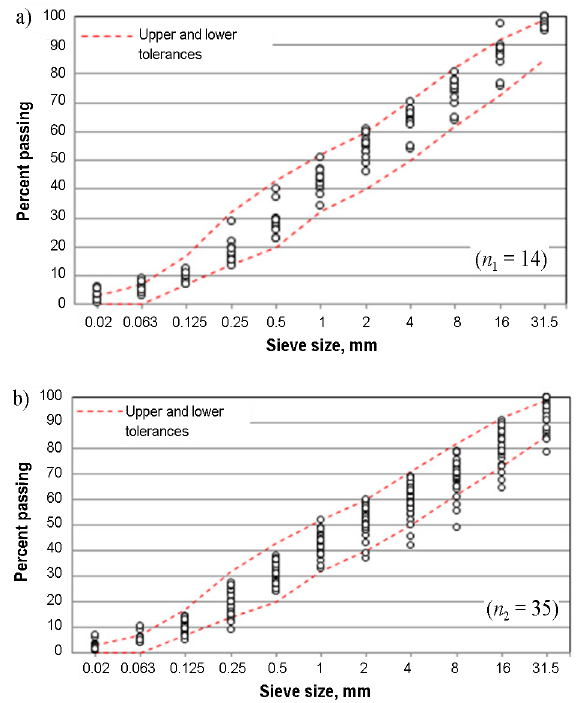
Fig. 12. Diagrams of gradation for samples taken from – a the stockpile, and b – the railway layer.